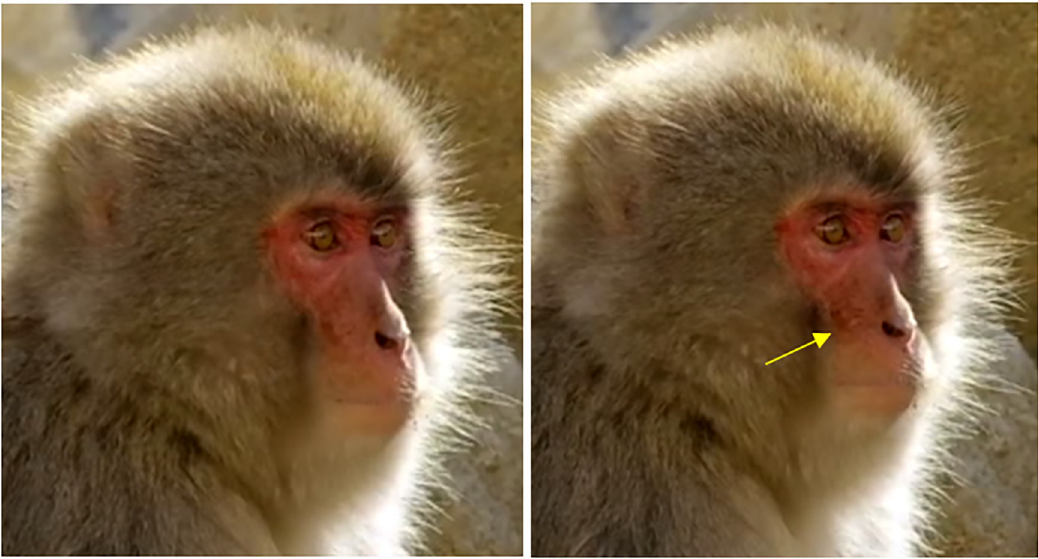
Fig 8. Left: Neutral; Right: AU10 with low intensity (arrow indicates wrinkles perpendicular to the nose and shortening of IOT).